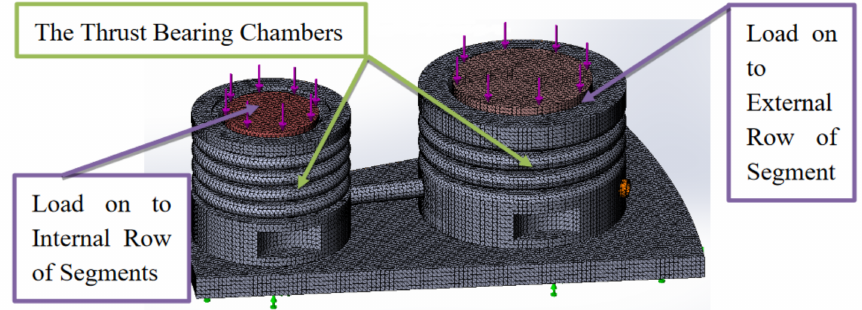
Figure 5. Calculation Diagram and limiting conditions of the thrust bearing unit loading.